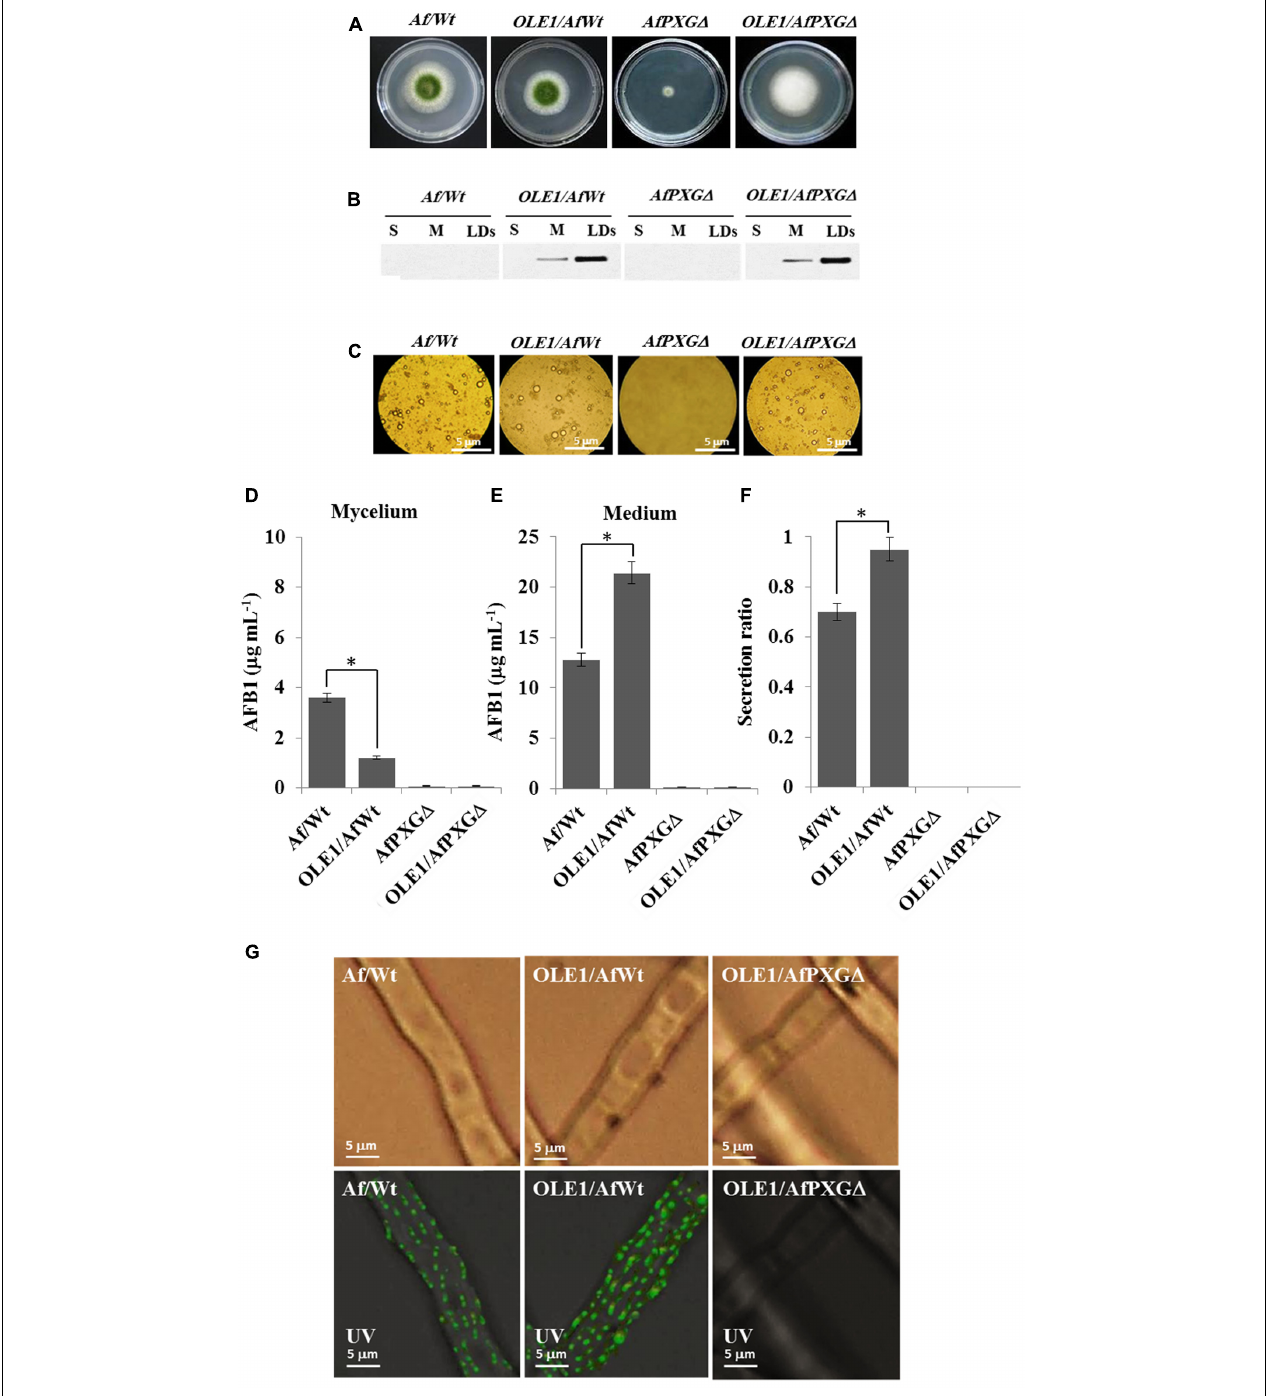
FIGURE 8 | Effect of the oleosin1 (OLE1) expression on fungal growth and AFB1 secretion. (A) Five-day-old cultures of transformants OLE1/AfWt and OLE1/AfPXG (cid:49) compared with their respective background lines AfWt and AfPXG (cid:49) . (B) Immunodetection of OLE1 protein in different subcellular fractions, supernatant (S), microsomes (M), and lipid droplets (LDs) isolated from the transformants OLE1/AfWt and OLE1/AfPXG (cid:49) compared with their respective background lines. (C) Light micrographs of the isolated LDs from the respective lines. (D,E) Quantification of AFB1 production in fungal mycelia and in the culture medium of transformants compared with background lines. (F) Secretion ratio of AFB1 by both transformants (calculated as ratio of AFB1 in the medium to AFB1 in medium plus mycelia in a 100 mL culture) compared with control lines. (G) Fluorescence image showing aflatoxin on the cell surface. The immunodetection of AFB1 was performed by its primary antibody coupled with a FITC-labeled secondary antibody. The measurements were done in triplicates. Values are means ± SD ( n = 3). The differences in AF production between lines were significant when analyzed by t -test ( ∗ P < 0.05).